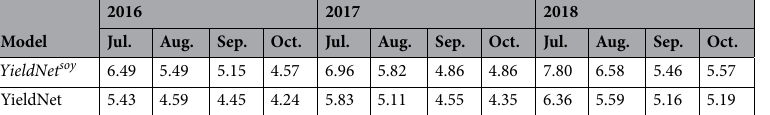
Table 9. The RMSE of the soybean yield prediction performances of the YieldNet and YieldNet soy models. The unit of yield is bushels per